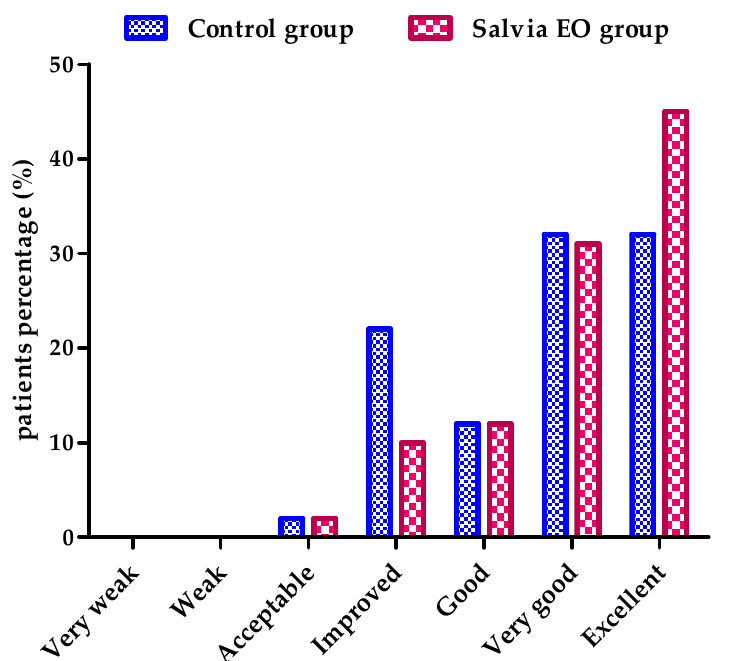
Figure 3. Patients’ satisfaction with the treatment they received during their current hospitalization (Mann–Whitney U test).